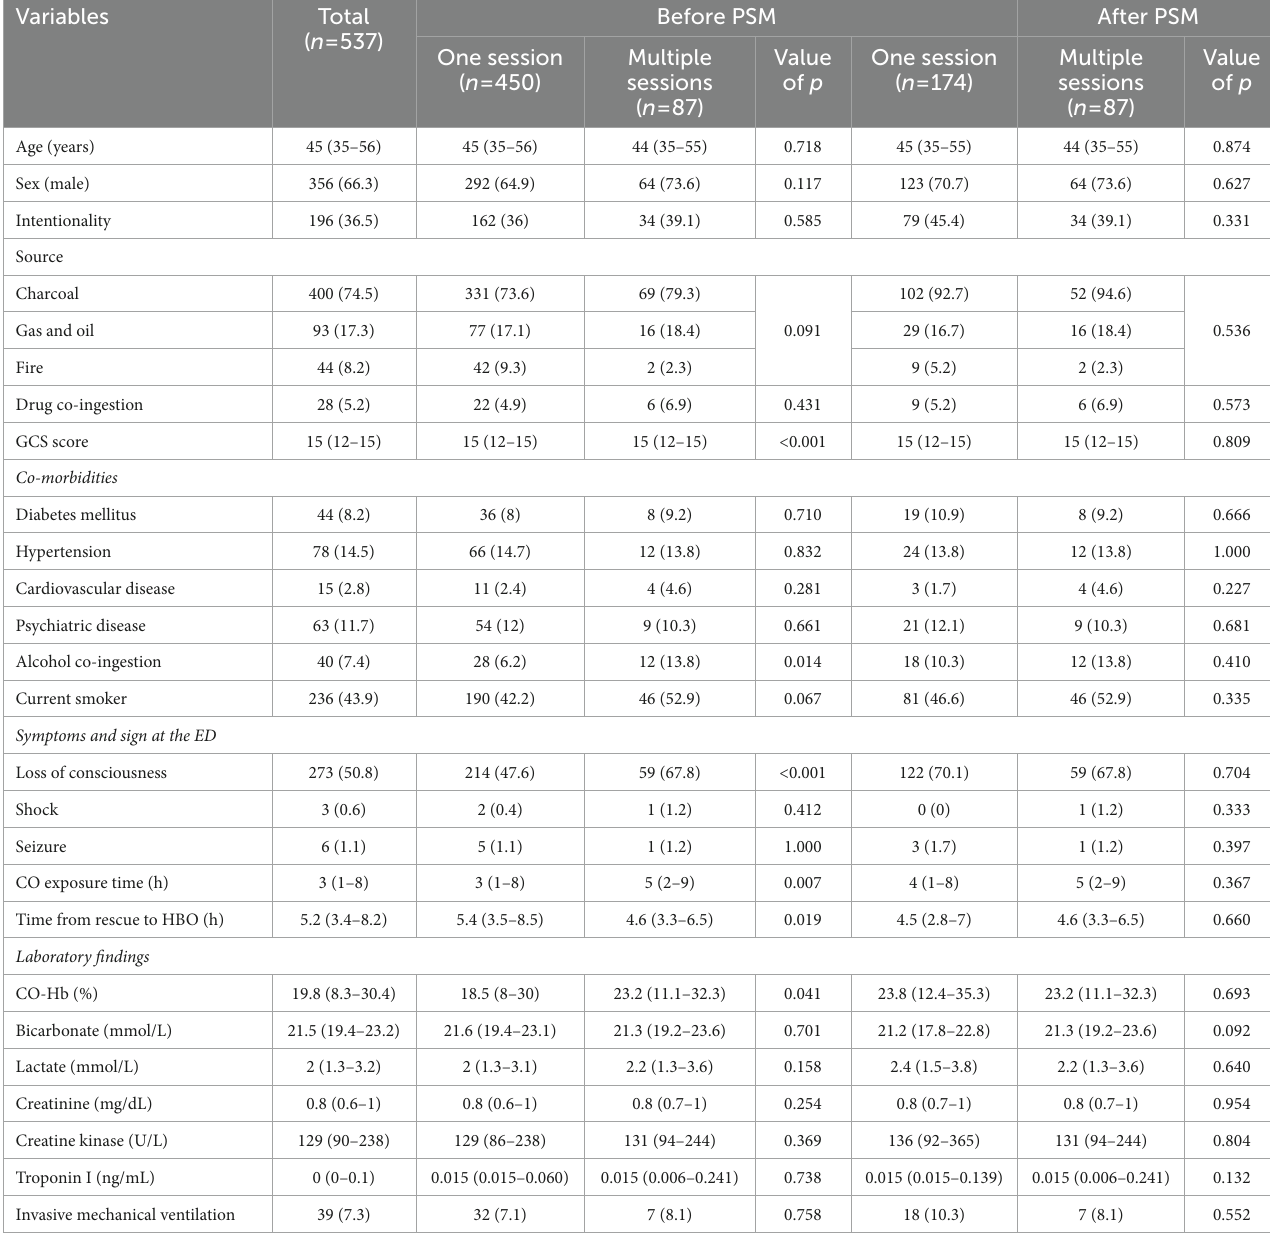
TABLE 1 Baseline characteristics in the total